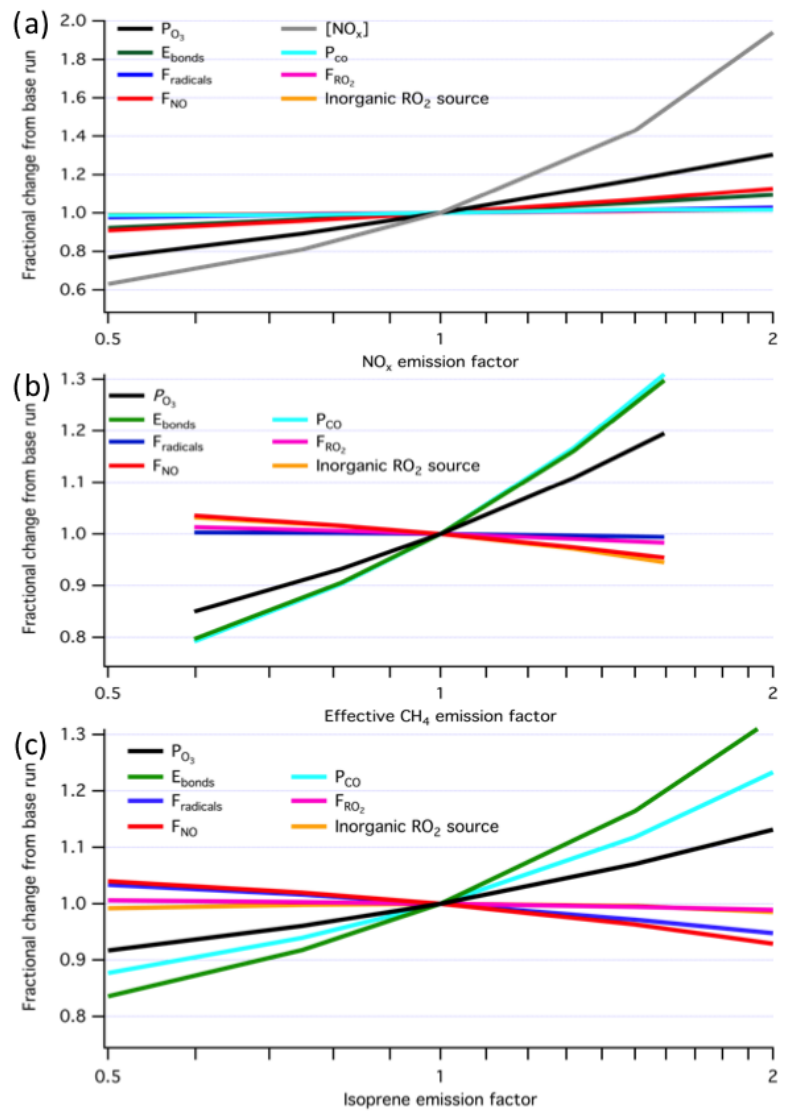
Figure 5. Fractional change in new P s O 3 diagnostic parameters from base run against changing NO x emission (a) ; effective CH 4 emis- sion (b) ; and isoprene emission (c)